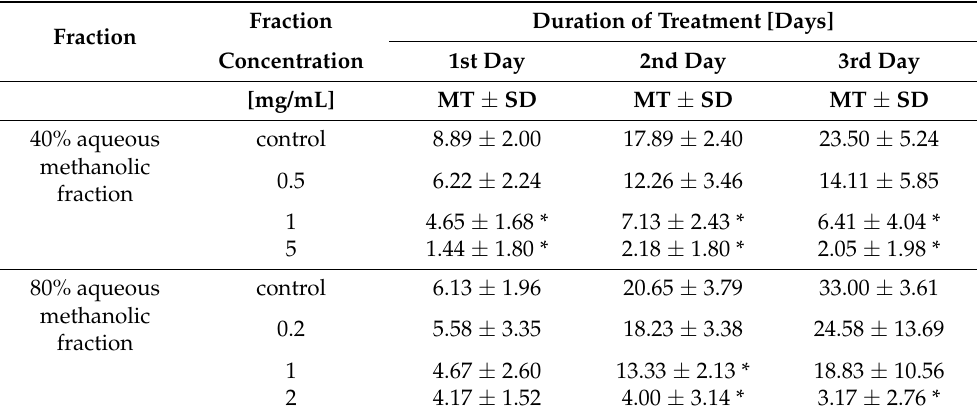
Figure 5. The effect of the 40% and 80% methanolic fractions of Lychnis flos-cuculi callus extract on the inhibition of Acanthamoeba trophozoite proliferation in the culture medium. Table 4. The effect of the 40% and 80% aqueous methanolic fractions of the extract from roots of micropropagated Lychnis flos-cuculi at different concentrations on Acanthamoeba trophozoite inhi- bition during three-day treatment.